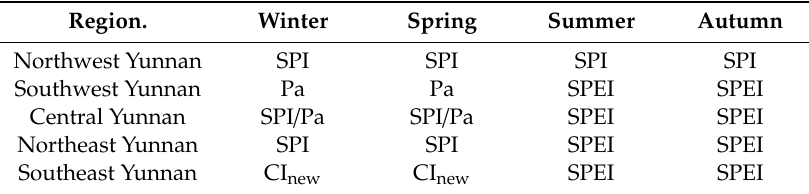
Table 1. Suitable drought index in di ff erent regions and seasons.